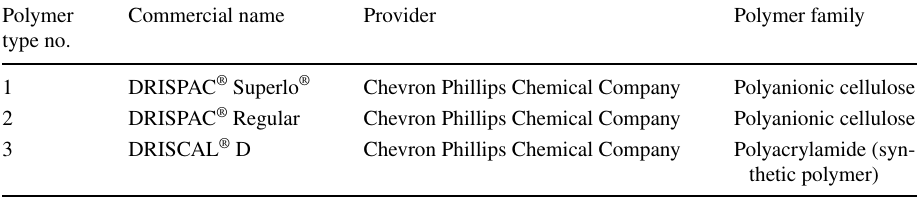
Table 1 The specifications of the polymers used in this study